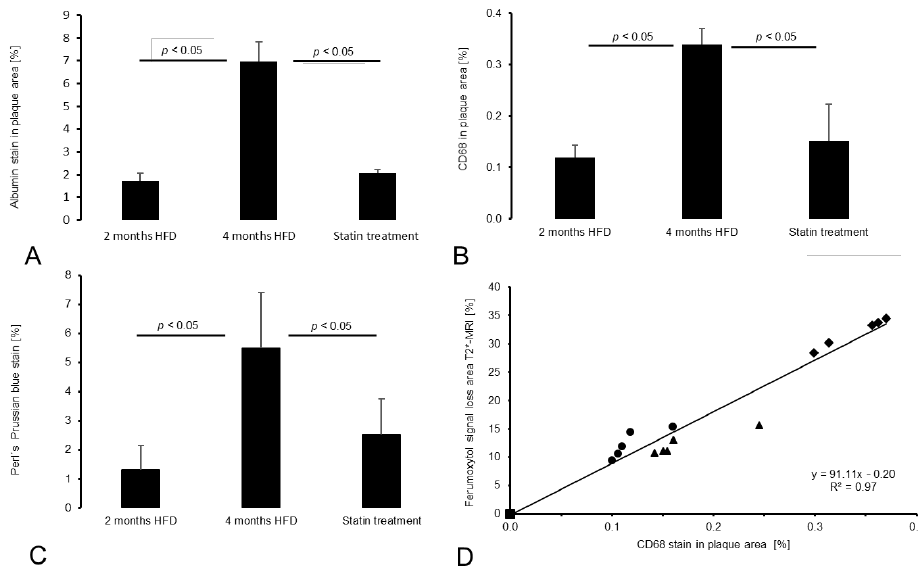
Figure 4. Histological analysis. ( A ) The bar chart shows the averaged fluorescent serum albumin- stained areas [%] within plaques for the three experimental groups ( n = 5/group). ( B ) Macrophage- specific CD68 staining in the plaque area [%] of the experimental groups is demonstrated ( n = 5/group). ( A ) and ( B ) Both fluorescent staining methods indicate significant differences in the 2 months HFD group and the statin treatment group compared with the 4 months HFD group ( p < 0.05). In contrast, the 2 months HFD and the statin treatment group do not differ significantly ( p > 0.05). ( C ) The Perls’ Prussian blue stain area [%] within plaques of the experimental groups show significant differences in the 4 months HFD group compared with the 2 months HFD group as well as the statin treatment group ( p < 0.05). In contrast, the 2 months HFD group and the statin treatment group do not differ significantly ( p > 0.05; n = 5/group). ( D ) The scatter plot indicates a strong correlation of CD68 macrophage staining in the plaque area and the T2* signal loss area ( p < 0.05; n = 5/group). Symbols: square—control group; triangle—statin treatment group; circle—2 months HFD group; diamond—4 months HFD